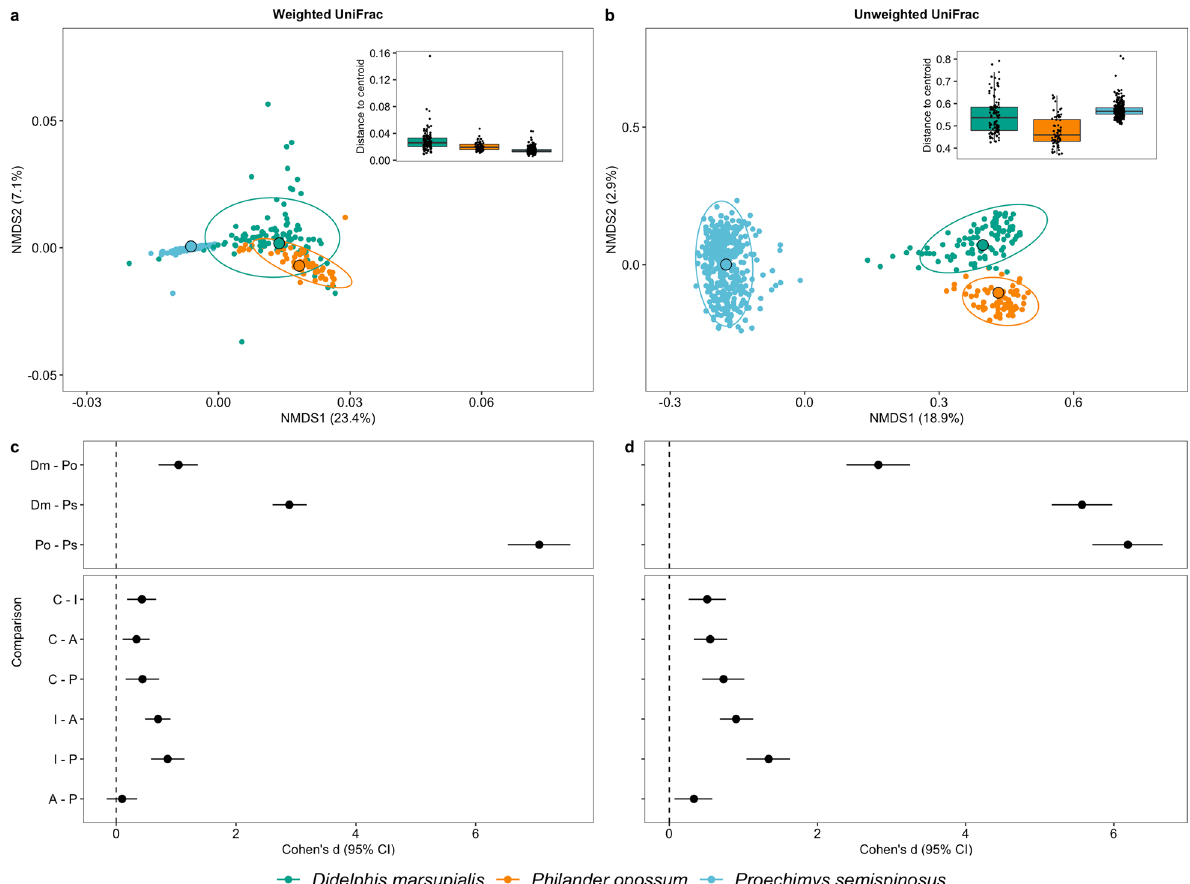
Fig. 2 Differences in beta diversity between three sympatric generalist species, the marsupials D. marsupialis (Dm, green), P. opossum (Po, orange), and the rodent P. semispinosus (Ps, blue). The top row shows NMDS plots of a weighted and b unweighted UniFrac distances. The bottom row c , d displays corresponding forest plots with Cohen’s d effect sizes highlighting the phylogenetic signal and landscape effects, i.e. the different levels of anthropogenic disturbance. Details on the landscapes C, I, A and P are provided in the methods and their locations are shown in Additional file 1: Fig.